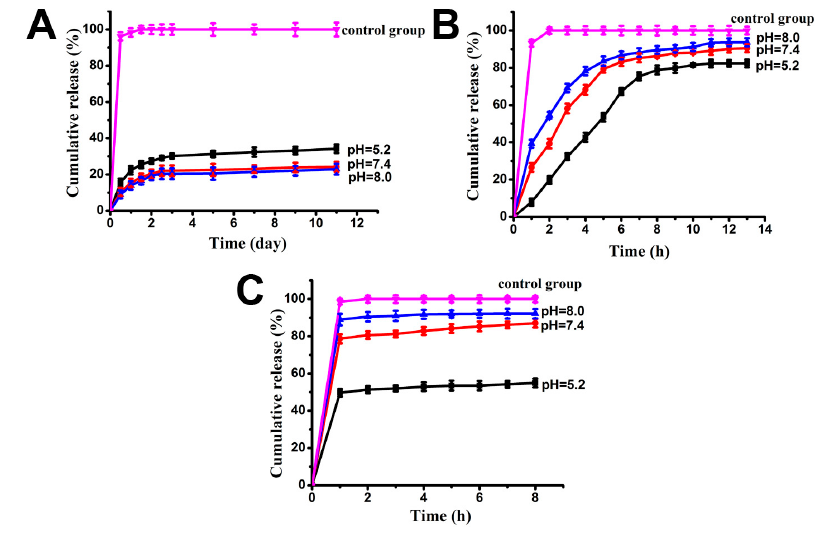
Figure 4. Cumulative release of model drugs from Ap F nanopartcles. ( A ) Positively-charged DOX